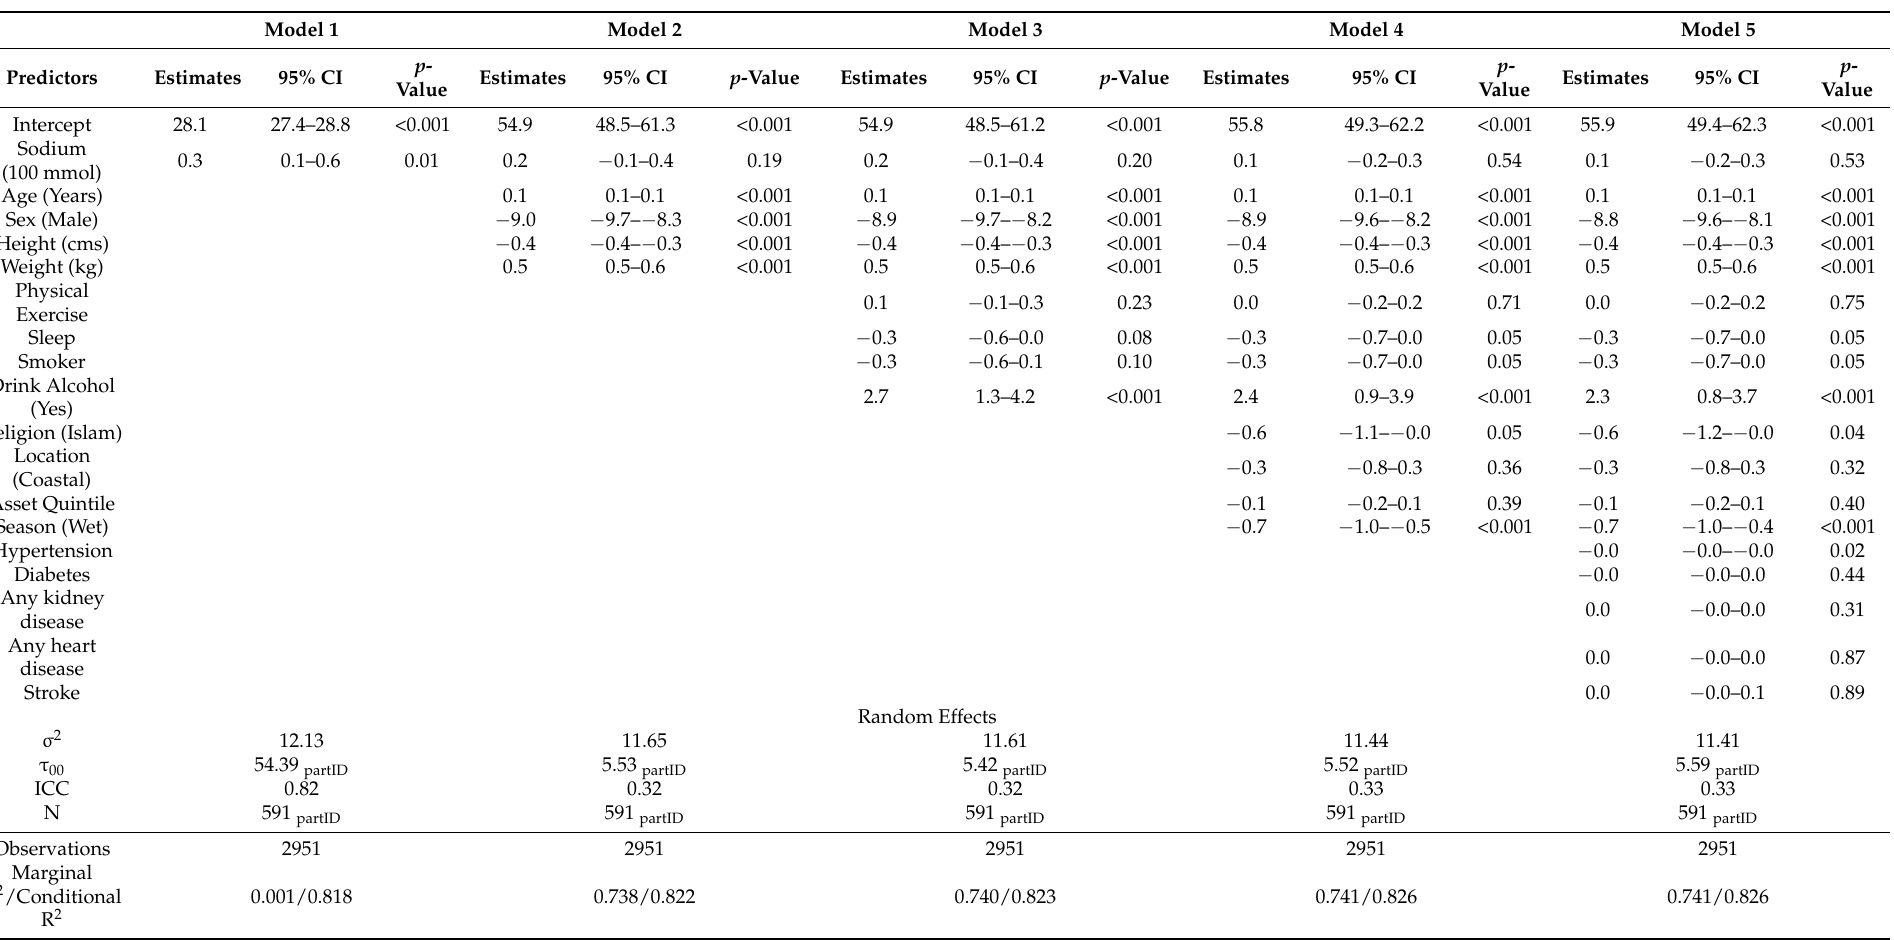
Table 6. Association between 24 h urinary sodium and mean body fat